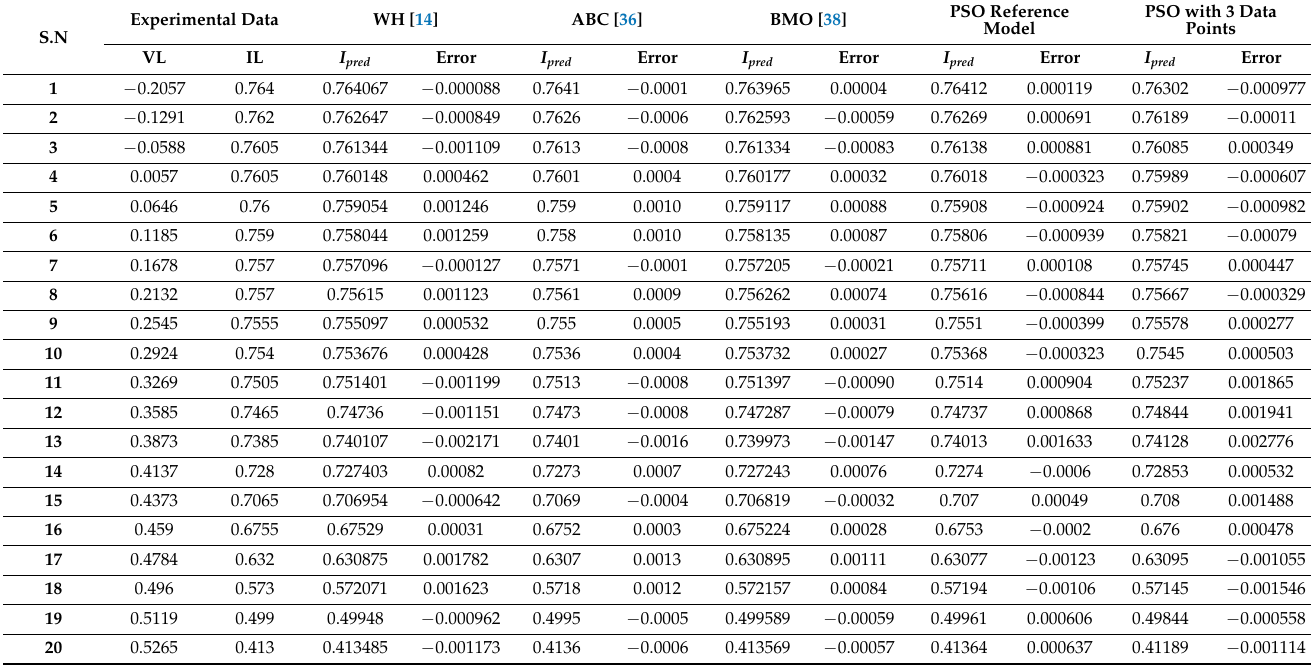
Table 4. Experimental I-V dataset for R.T.C. France solar cell